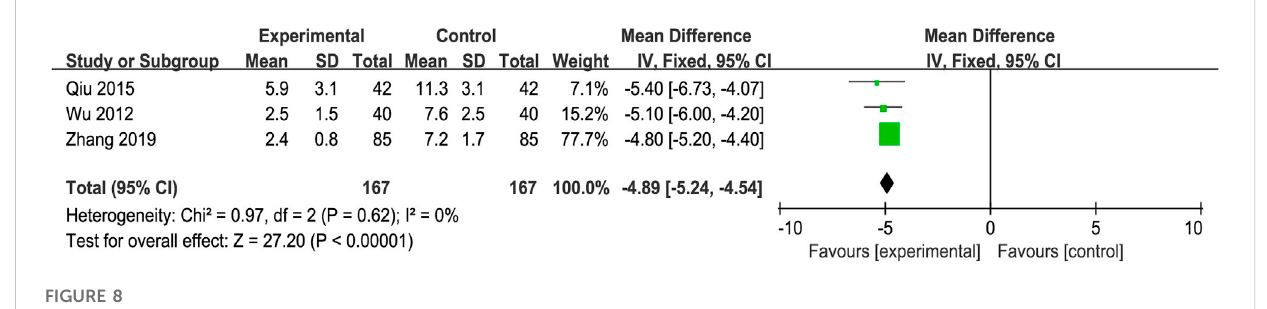
FIGURE 8 Forest plot of meta-analysis of syndrome score.